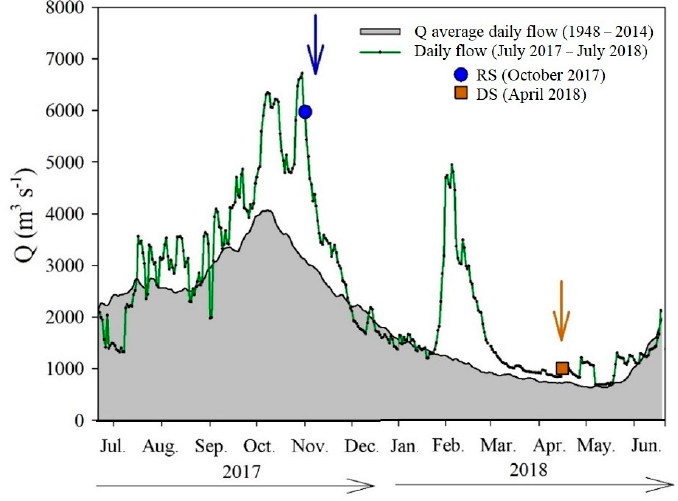
Figure 2. Variations in the historical (1948–2014) average daily flow (grey area) and the 2017 (RS) to 2018 (DS) flow measured at the hydrometric station at Boca del Cerro (M10), Tabasco. High water temperatures (mean 26.5 ± 2.3 °C) prevailed in both sampling campaigns, ranging between 20.8 °C (M1, RS) and 29.8 °C (M7, DS). The DO of the Usumacinta River